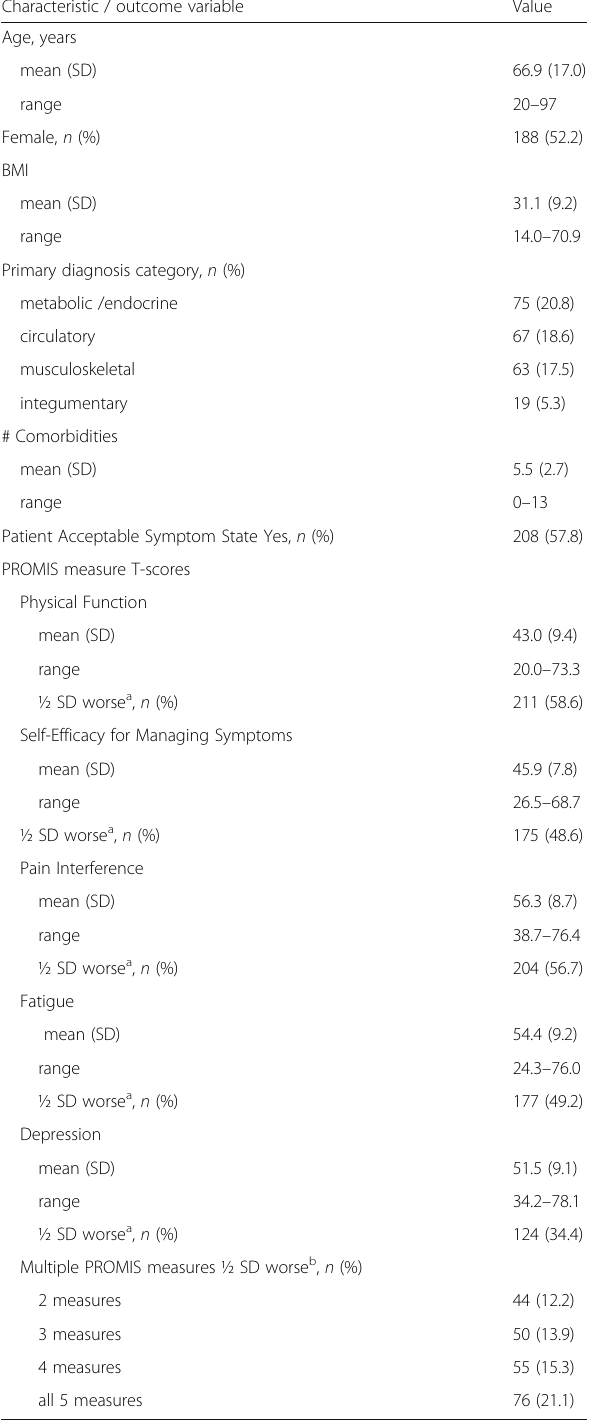
Table 1 Sample characteristics and patient-reported outcomes data for all patients at intake ( n = 360) Characteristic / outcome